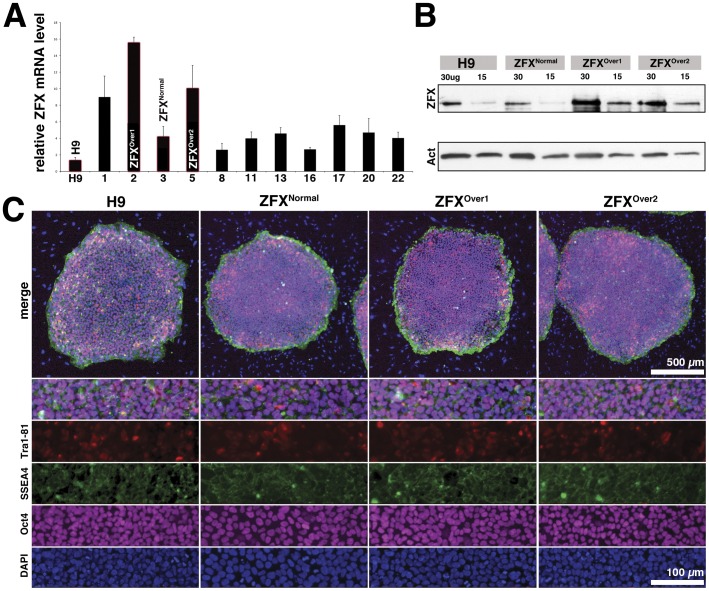
ZFX BAC transgenic human embryonic stem cells.A. Normalized ZFX expression levels from G418-resistant hESC clones with the original clone names shown on the x-axis. Three clones were renamed ZFXOver1, ZFXOver2 and ZFXNormal were selected for further analysis. ZFXNormal showed normal levels of ZFX but had undergone the same clonal and selection steps as ZFXOver clones. B. ZFX and actin protein levels determined by Western blot analysis of ZFXOver clones and controls. C. Oct4 (purple), SSEA-4 (green), Tra1-81 (red) and DAPI (blue) on ZFXOver clones and controls. Scale bar  = 500 µm (low) or 100 µm on the high magnification images.